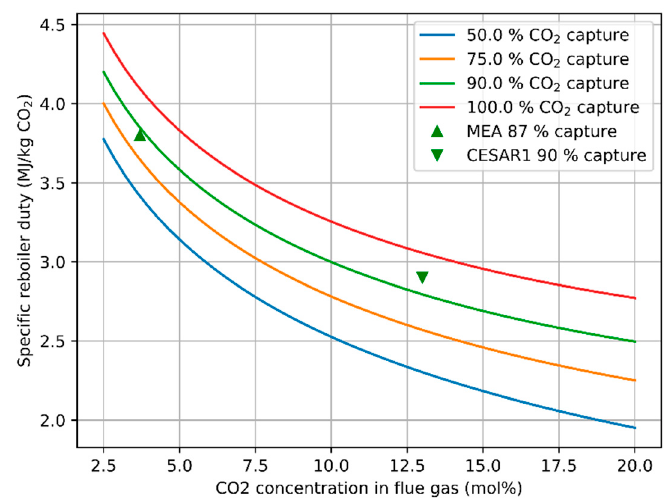
Figure 5. Estimated specific reboiler duty for a generic solvent as a function of CO 2 capture rate and flue gas concentration. Based on theoretical work of mixing [40] and normalised with results for 30 wt% MEA [39]. The performance of the CESAR1 solvent (90% capture rate, 13 vol% CO 2 ) [41].